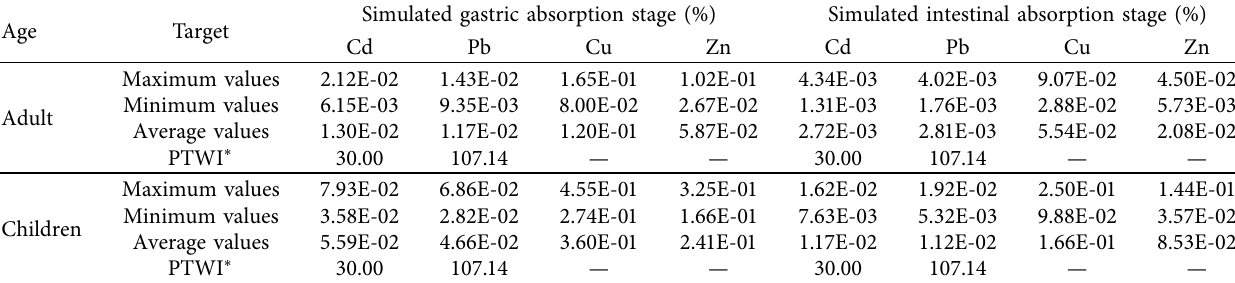
Table 6: Bioavailability of heavy metals in different digestive stages of adults and